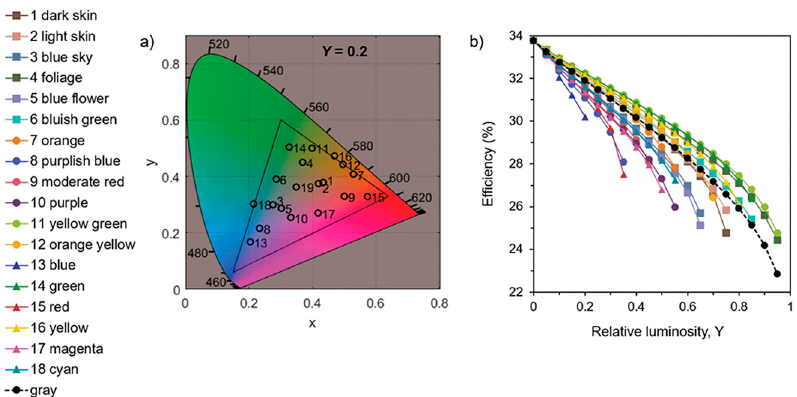
Figure 5. Effects of colour brightness (relative luminosity, Y ) on the theoretical efficiency limits (subfigure ( b )) for different colours, represented on the trichromatic chart in subfigure ( a ). Reproduced from ref. [15] with permission from the Royal Society of Chemistry.